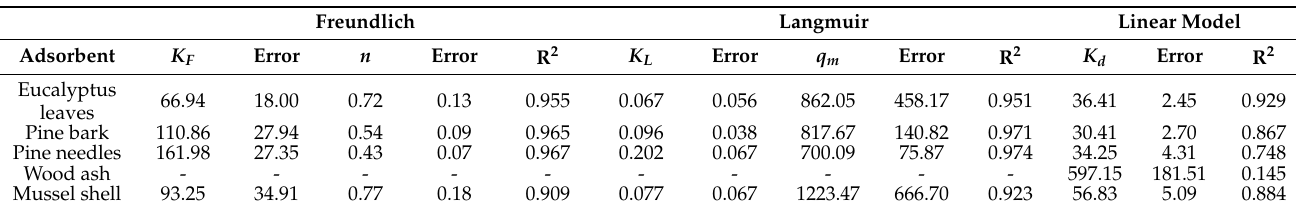
Table 2. Fitting of the adsorption data to the Freundlich, Langmuir, and Linear models. K F (L n µ mol 1 − n kg − 1 ); K L Freundlich